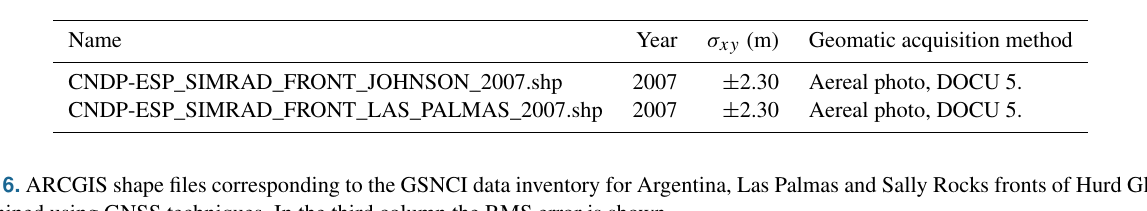
Table 5. ARCGIS shape file corresponding to the satellite image of QUICKBIRD system program (2007). The image is corrected to sea level to obtain the correct planimetric position of the glacier fronts. In the third column the RMS error is shown.